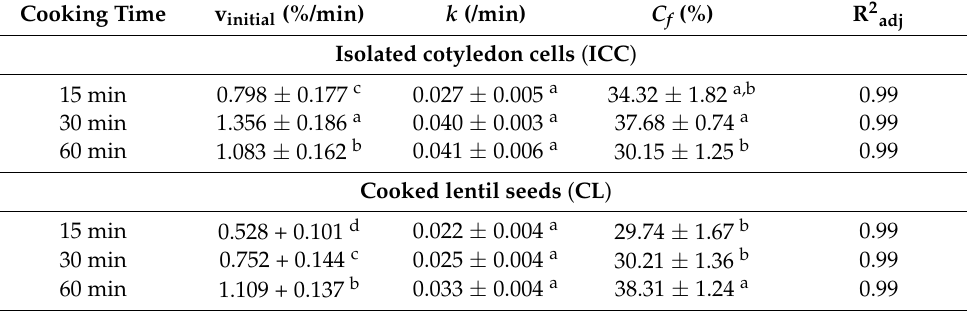
Figure 5. The formation of readily bioaccessible proteins as a function of the digestion times of ( a ) isolated lentil cells derived from lentils cooked for ( ○ ) 15, ( ∆ ) 30, and ( □ ) 60 min, and ( b ) whole lentil seeds cooked for ( ● ) 15, ( ▲ ) 30, and ( ■ ) 60 min. Symbols represent experimentally determined data. Lines represent the data modeled using the fractional conversion model (Equation (3)). Error bars indicate the standard deviation of analytical replicates. Table 3. Kinetic parameters (± standard deviation) estimated using the fractional conversion model (Equation (3)) for in vitro proteolysis of whole cooked lentil seeds (CL) and isolated cotyledon cells (ICC) for different cooking times. The estimated kinetic parameters include the rate constant k , final extent of proteolysis C f , and the initial proteolysis rate (v initial ). Within a column, different letters in superscript indicate significant differences between means based on 95% confidence intervals.